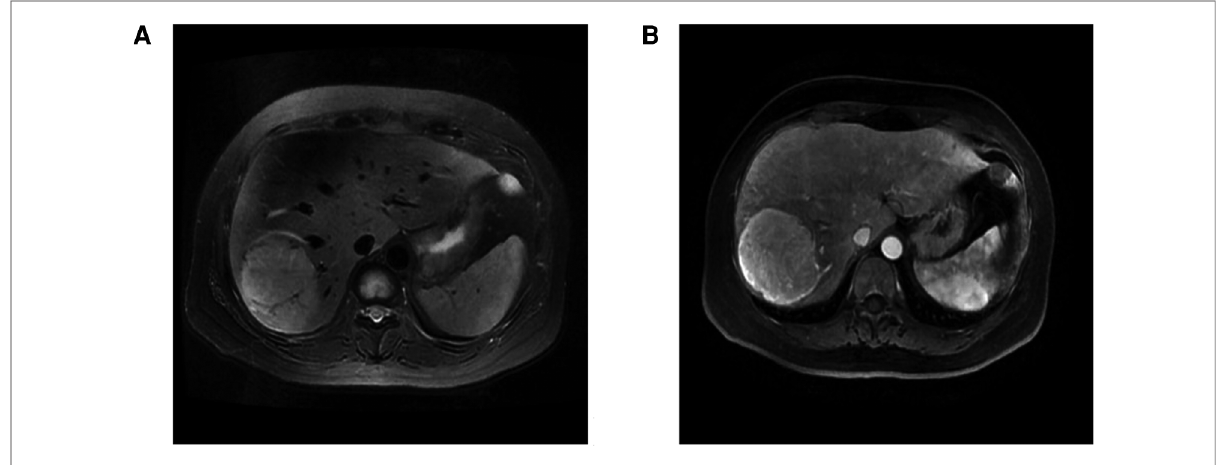
FIGURE 1 MRI of in fl ammatory myo fi broblastoma of the liver. ( A ) shows the MRI plain T2-weighted image (T2WI). ( B ) shows the enhanced scan image.